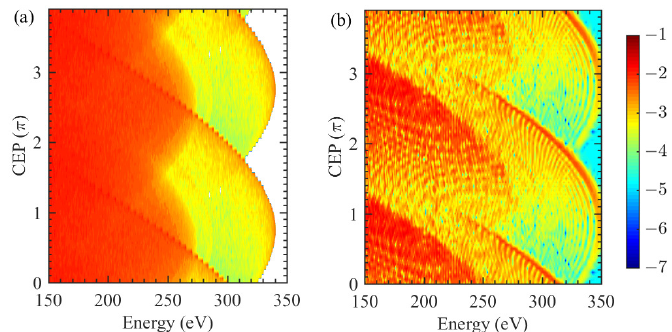
Figure 7. (color online) CEP-dependent energy-resolved photoelectron spectra (log scale) at a laser wavelength of 3200nm, keeping the other laser parameters the same as those in Figure 3. ( a ) results using the CTMC method, ( b ) the same as ( a ), but using the TDSE approach. In this figure, only the region of high electron energies is